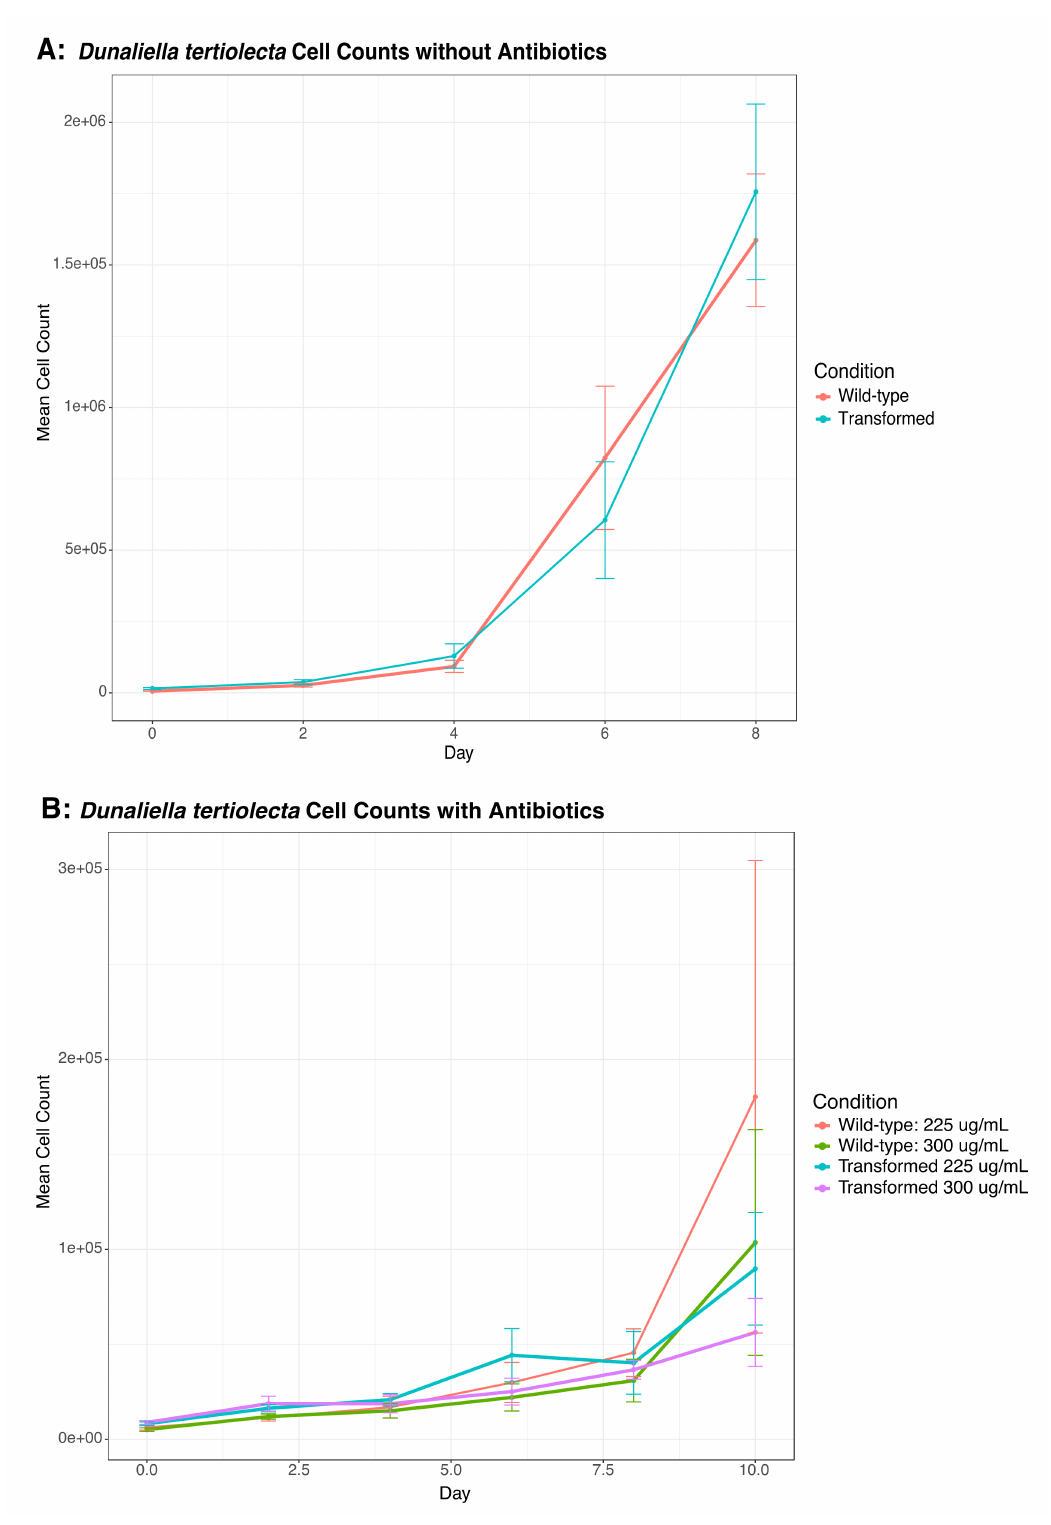
Figure 4. Cell counts for D. tertiolecta cells that were either transformed or wild-type cells; ( A ) Both transformed and wild-type growth curves for D. tertiolecta without antibiotics; ( B ) D. tertiolecta cells grown under rifampin at either 225 or 300 µ g / mL. The center values represent the means, with standard deviation as error bars. The results indicate that antibiotic resistance was not conferred when exposing D. tertiolecta to O. marina’s transformation